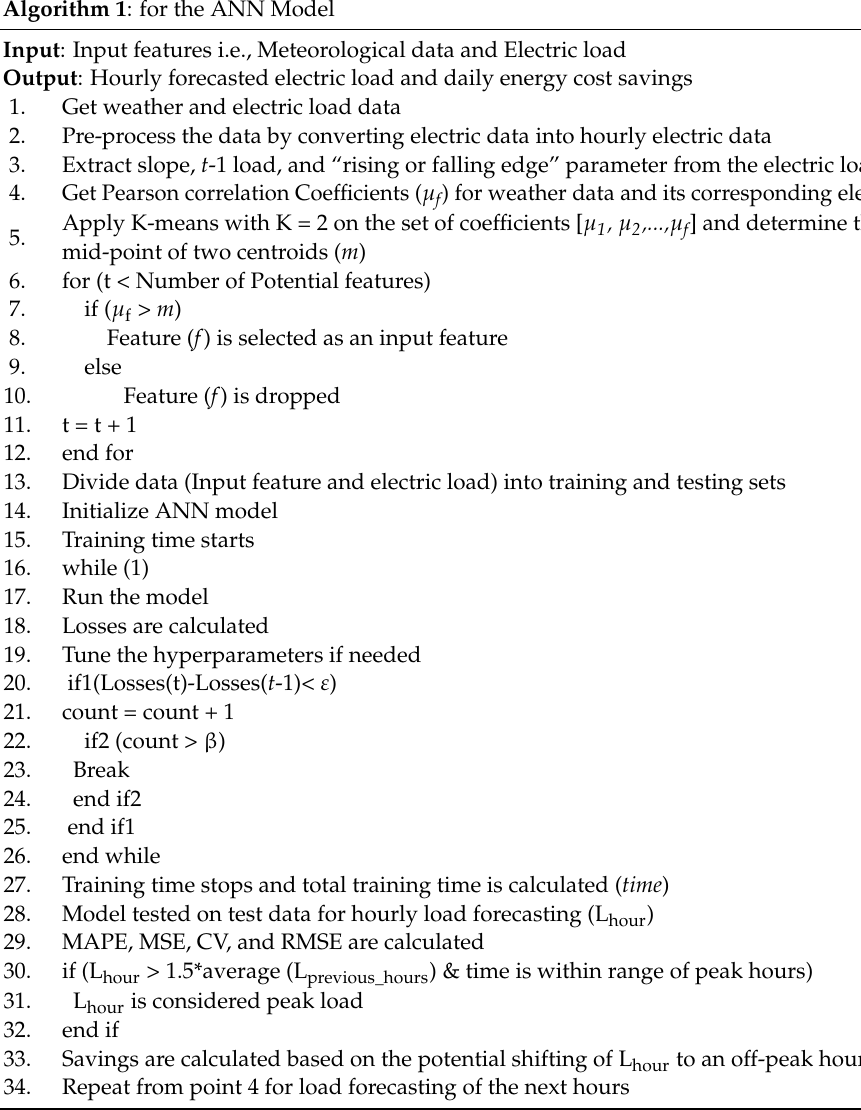
Algorithm 1 : for the ANN